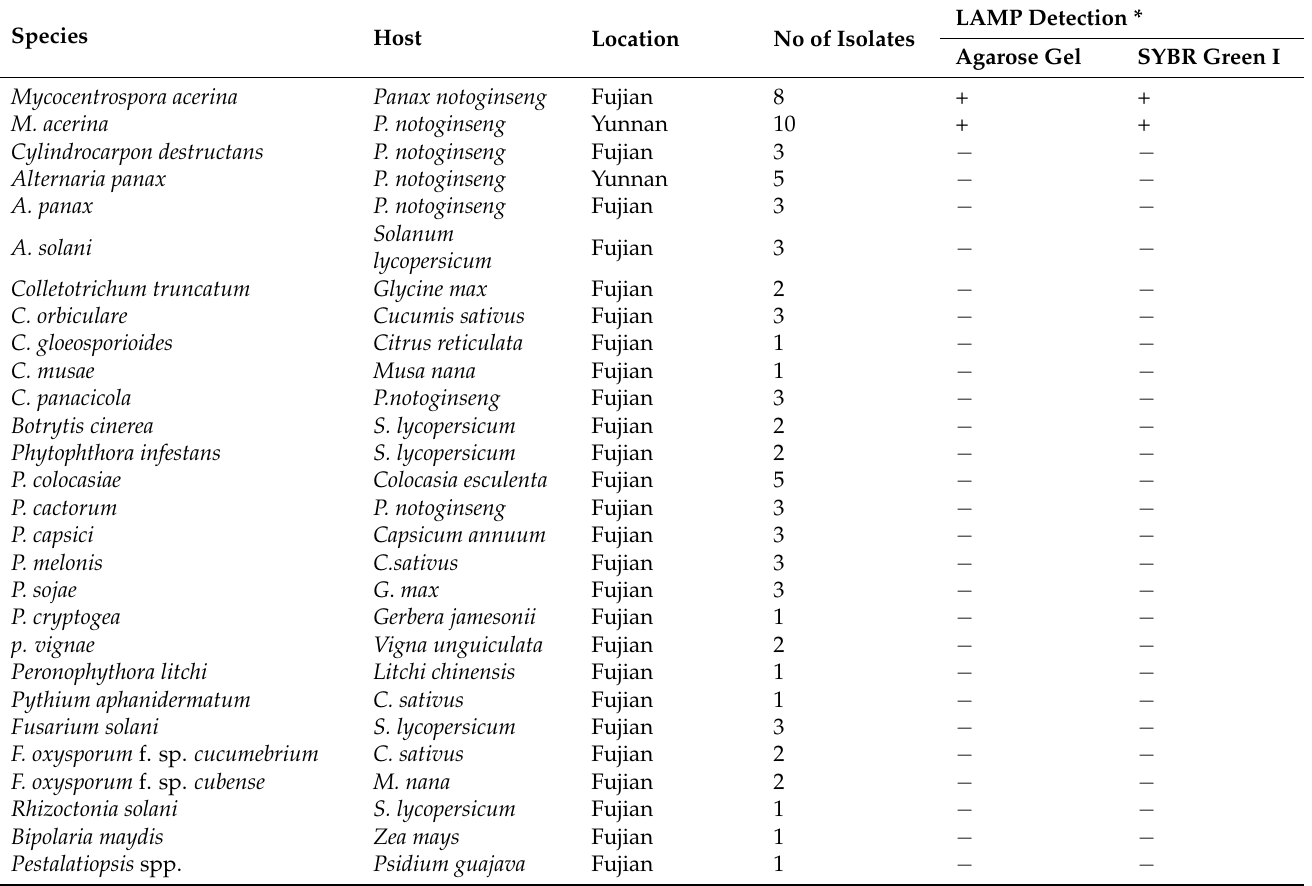
Table 1. Isolates of different plant pathogens used to test the specificity of the LAMP